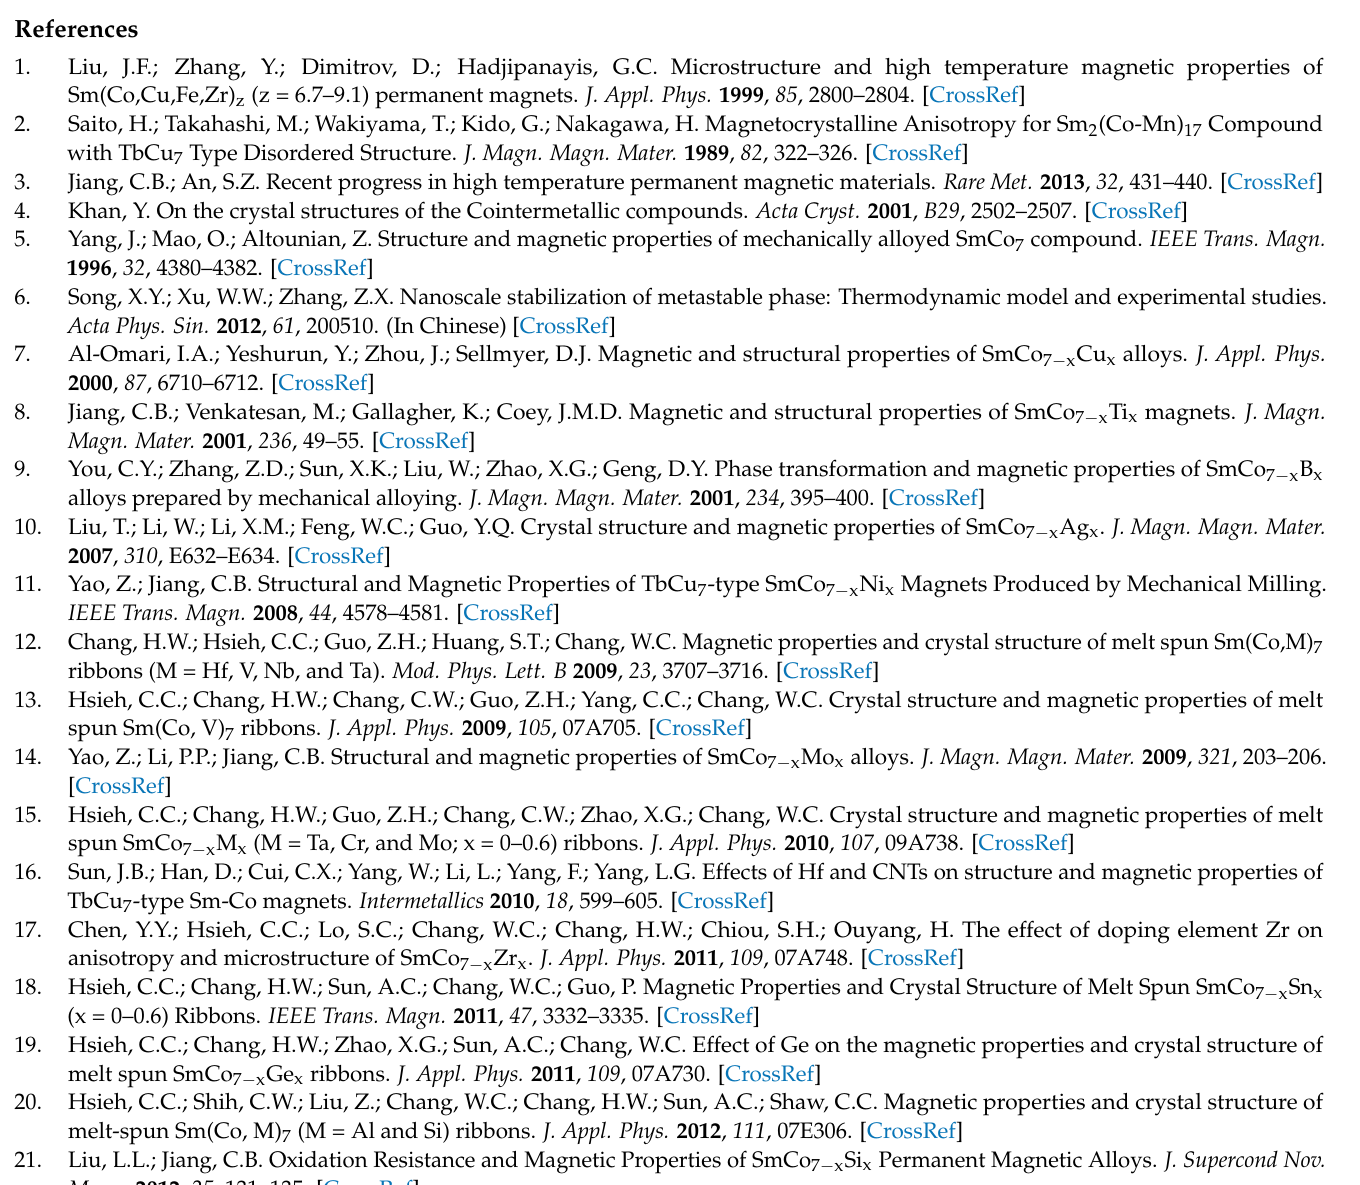
Table S2: The optimal features and the mean AUC with different number of features; Table S3: Design of independent variable space; Table S4: LTECV grouping